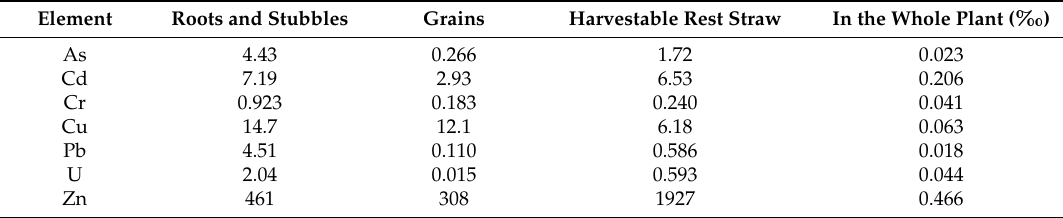
Table 6. The approximate order of N, P, and K extraction (kg ∙ ha − 1 ) by cv. JB Asano from soils A and C. Compare Tables 1 to 4 for primary data. In parentheses, the percentages of minerals in roots/stubbles to those of the harvestable crop. In brackets [ ], the mineral concentrations of the herbage (kg ∙ Mg − 1 ∙ DW).